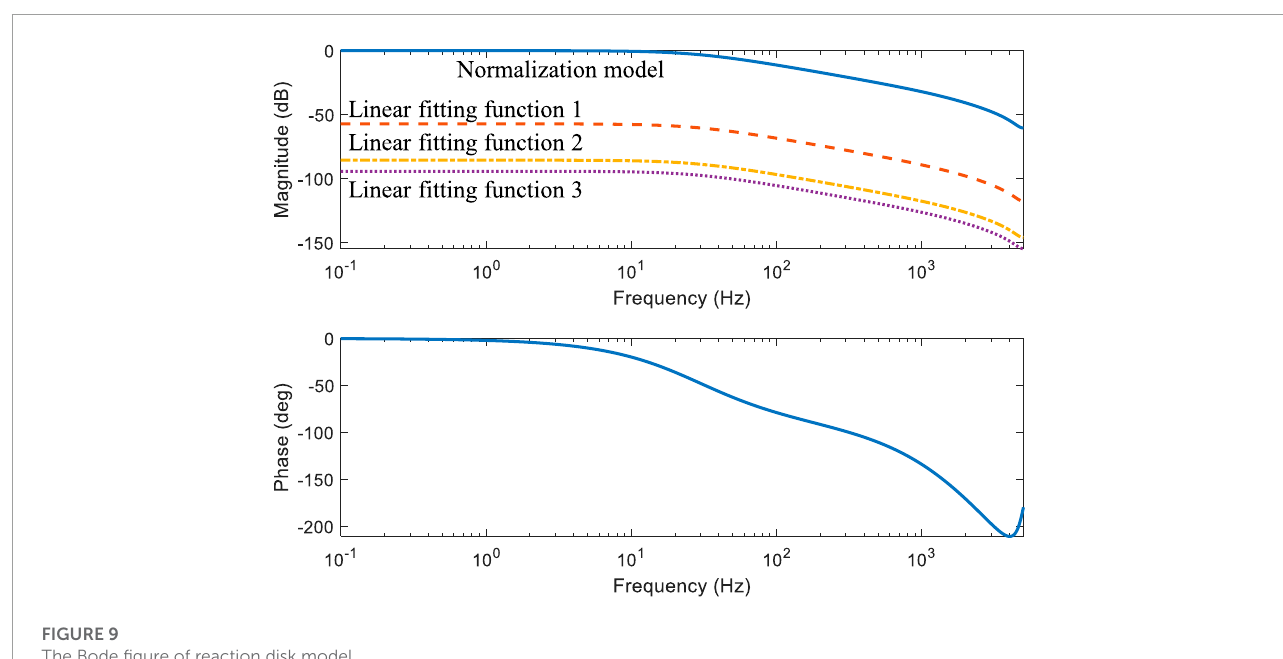
FIGURE 8 The stress vs. strain of the reaction disk.